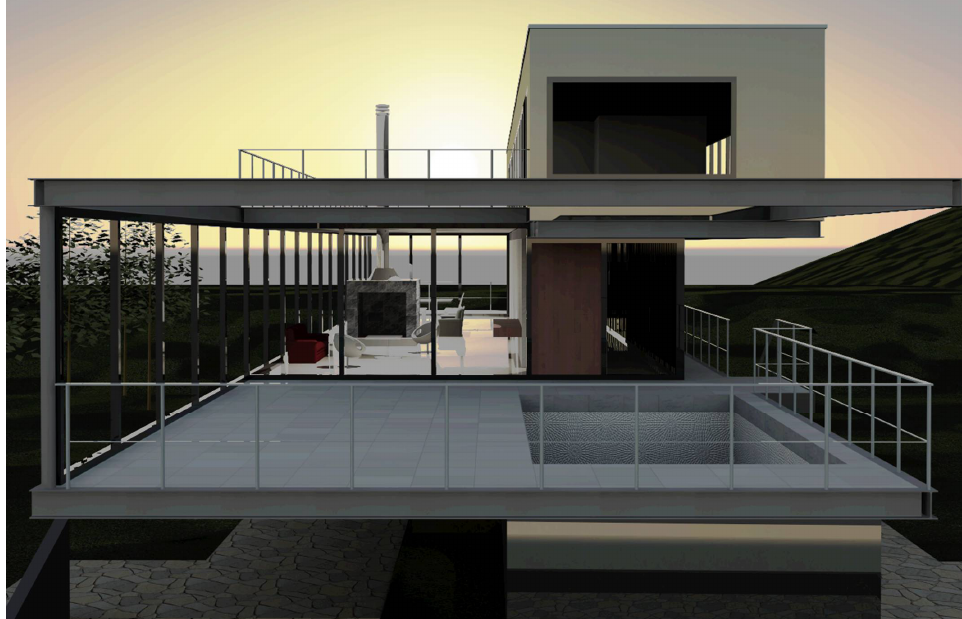
Figure 9. 3D Modeling and rendering. Mathias Klotz, Casa Ponce—Martínez San Isidro, Buenos Aires (student Stefano Di Carlo).